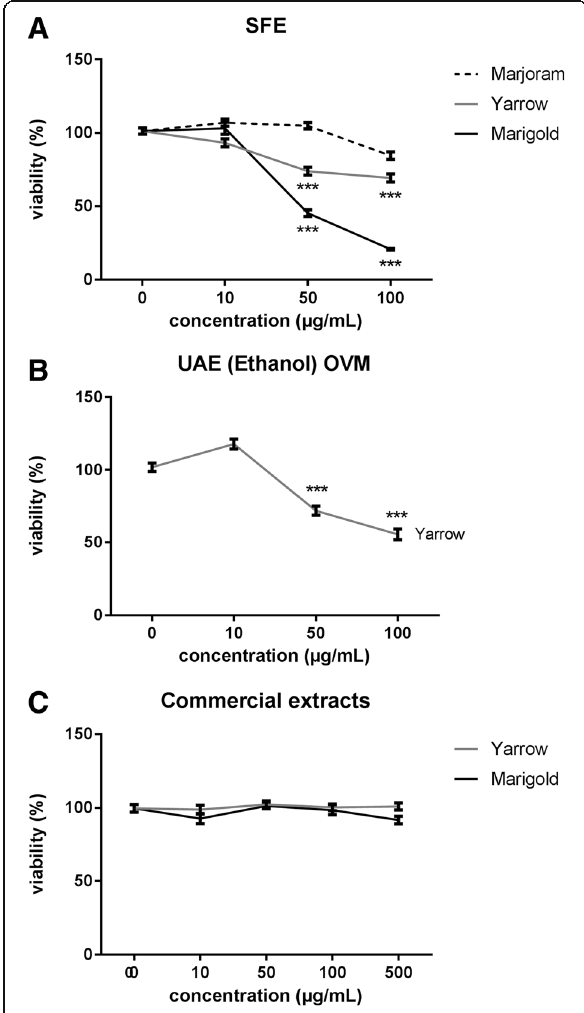
Fig. 3 Dose-response curves of cell viability assays after 48 h treatment of PANC-1 pancreatic cancer cells with increasing concentrations of SFE extracts ( a ), UAE (Ethanol) MVO extracts ( b ) and commercial extracts ( c ) for PANC-1. Data represent means ± S.E.M of at least three independent experiments each performed in quadruplicate. Asterisks indicate statistical differences in treated cells with respect to the control (non-treated cells, DMSO 0.1%). *** p <0.001